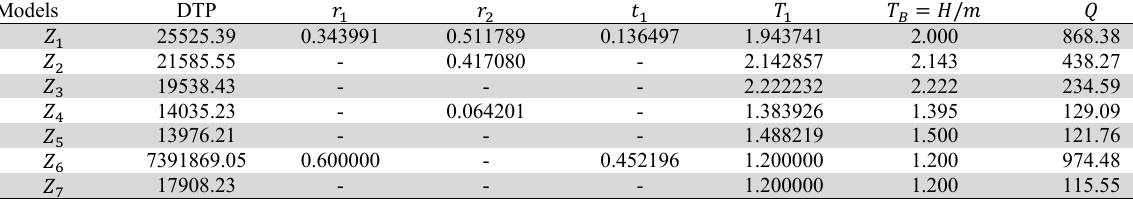
Optimal decision for the models considering TVM and shortages (Example 2) Models